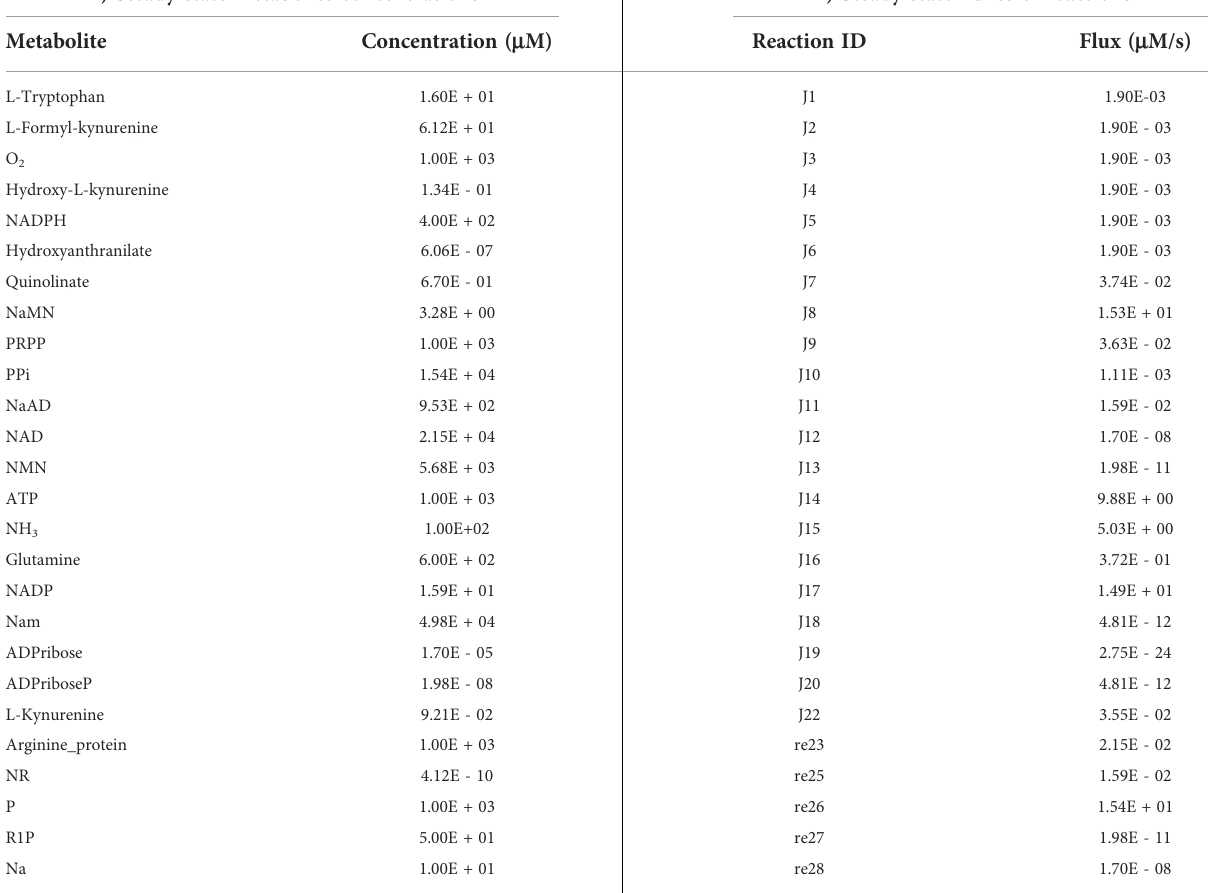
TABLE 2 Steady-state concentration of metabolite and fl uxes of